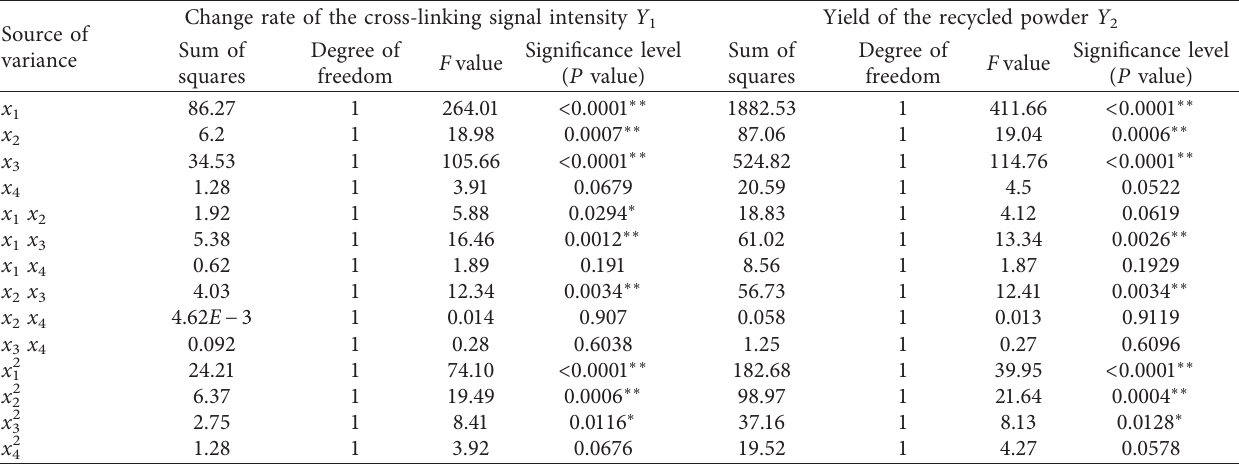
Table 5: Variance analysis of regression